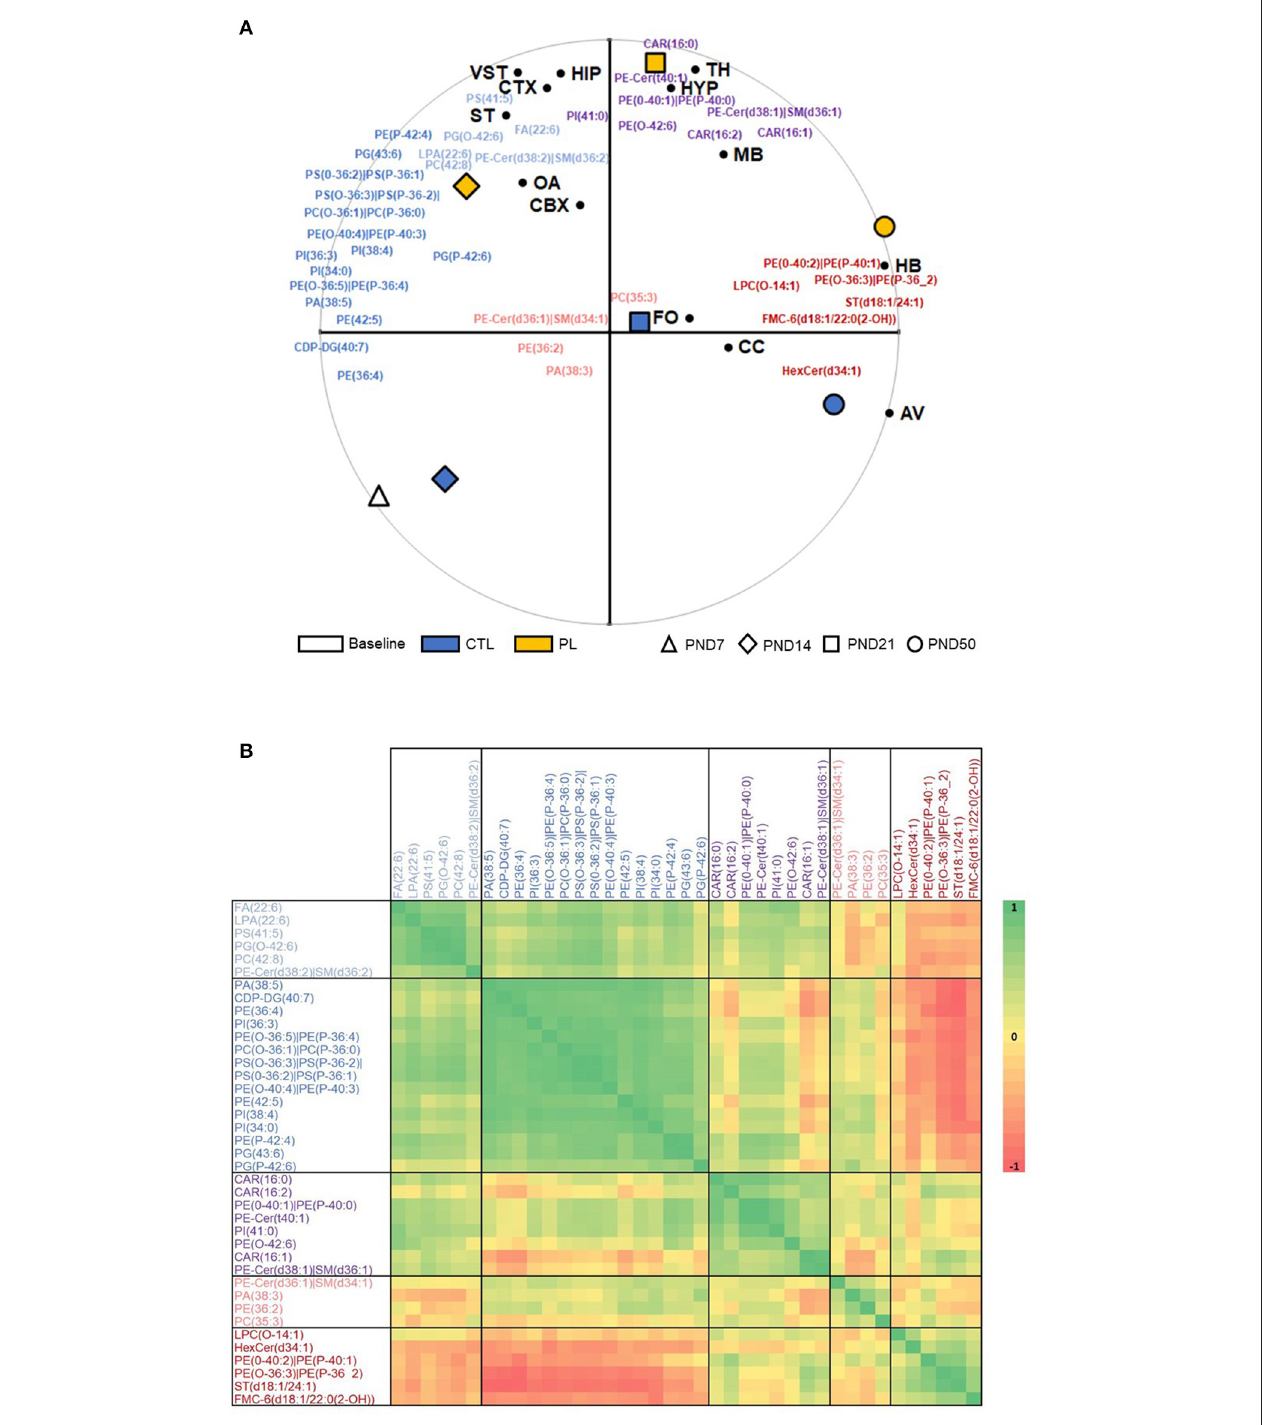
FIGURE 4 | Time-coordinated spatial distribution of annotated lipids. (A) Biplot of first and second principal components with Treatment x Age positioned relative to all annotated species are shown. PC1, accounting for 40%, is highly associated with developmental age, whereas PC2, accounting for 26%, is strongly differentiating the two treatments, revealing a similar pattern for these 39 annotated species compared to all 5241 m/z detected in the two ionization modes. The average positions of ROIs are further superimposed on this biplot. (B) Pearson correlation heatmap of all annotated species based on Treatment x Age x ROI z-scores on log-transformed data is shown. A total of five clusters were identified using the furthest neighbor aggregation hierarchical clustering. OA, olfactory area; CTX, cortex; ST, striatum; vST, ventral striatum; TH, thalamus; HYP, hypothalamus; MB, midbrain; HB, hindbrain; CBX, cerebellum; AV, arbor vitae; CC, corpus callosum; FO, fornix.